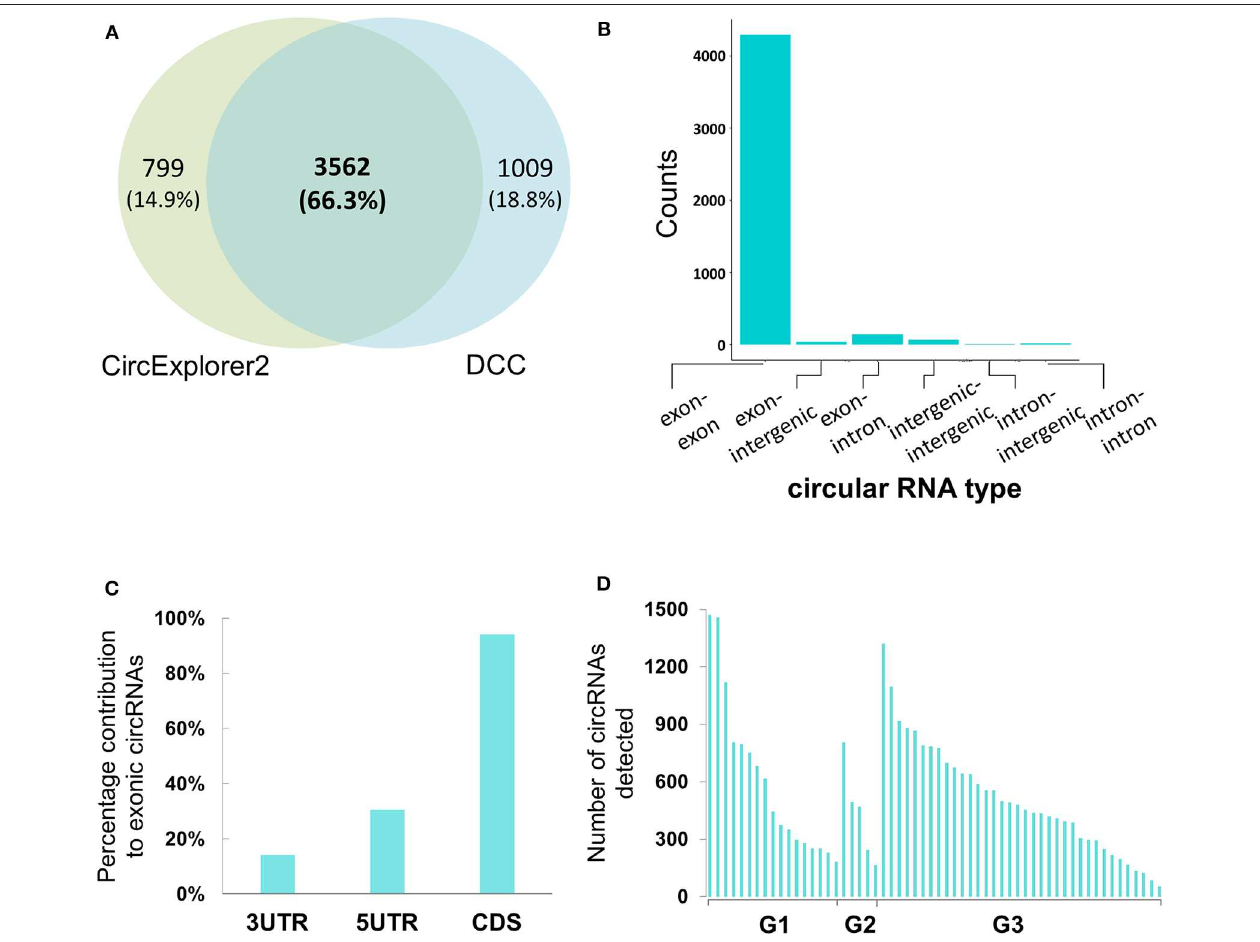
FIGURE 2 | Genomic characterization of potential circular RNAs in Bladder cancer samples (A) Co-ordinate level overlap between circular RNA candidates detected by CircExplorer2 and DCC, respectively. (B) Types of genomic origin for circular RNA candidates. X-axis is showing the genomic origin pair across the back-splicing junction. Y-axis is the count of circular RNAs obtained from that pair type. (C) Within mRNA positional bias for circular RNA candidates. X-axis represents the three classes of space within mature mRNA body. Y-axis is the percentage contribution of each space type to exonic circular RNA candidates. (D) Tumor-grade wise distribution of circular RNA candidates. X-axis represents the 58 tumor samples categorized by the tumor grades of G1, G2, and G3, respectively. Y-axis represents the number of circular RNAs detected with more than 4 back spliced reads in the tumor sample. ( Figure 2A ). In addition to the junction count for back-splicing events, the output from the DCC algorithm also provided the paired count for the linear events which allowed comparative evaluation; hence, for downstream analyses, results from the DCC were carried